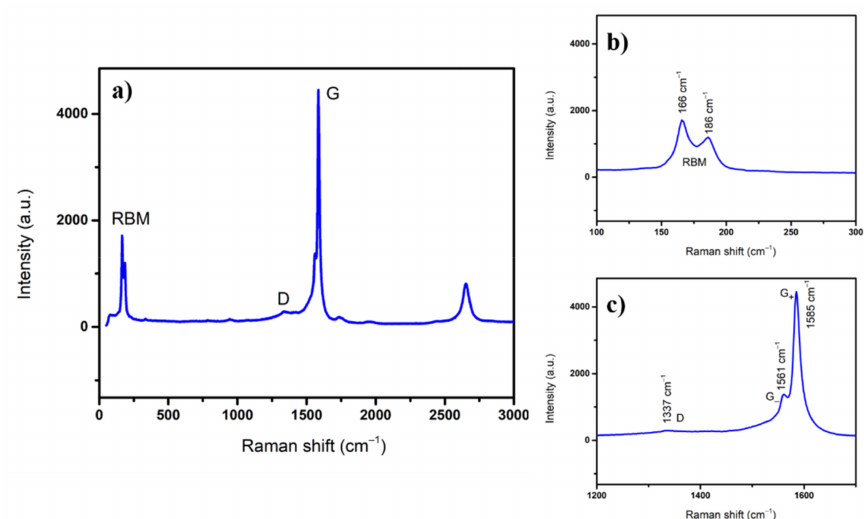
Figure 3. ( a ) Typical Single Wall Carbon Nanotubes (SWCNTs) Raman spectra; ( b ) radial breathing mode (RBM) band and ( c ) D and G